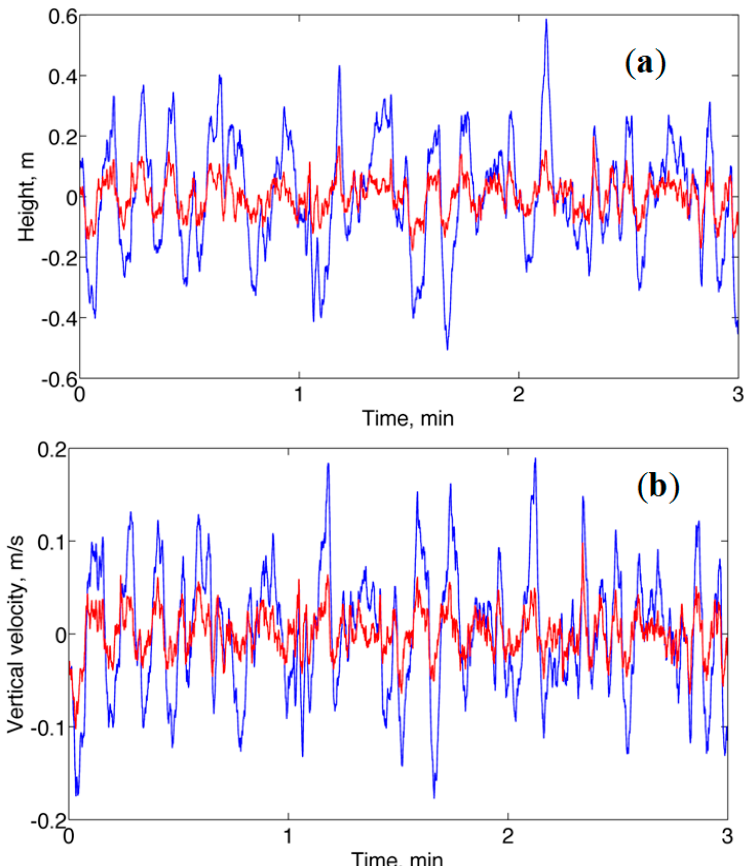
Figure 3. No-motion. ( a ) Height time functions are plotted in blue (Method A) and red (Method B); ( b ) Vertical velocity time functions are plotted in blue (Method A) and red (Method B). The reference height and vertical velocity are